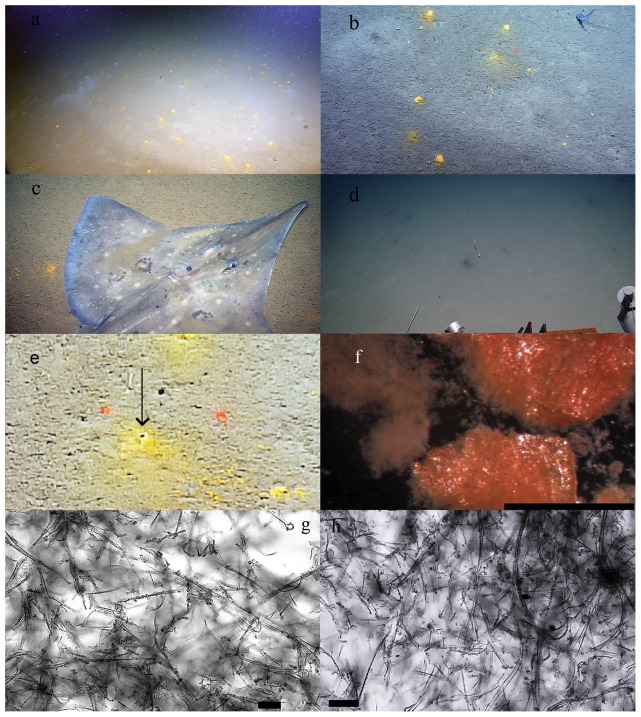
Images of the FeOB patchy mats observed in this study.a) Biofilm patches at the sediment-water interface of Dor disturbance. b) In situ close up image of the deposits, the distance between two red dots is 10 cm. c) Dipturus sp. re-suspending the deposits. d) Black-colored deposits in at 1000 m depth offshore Israel. e) Close up image of the FeOB patch. The arrow points at potential burrow opening at the core of the patch. f) Microscopic image of the deposits ex situ (scale bar is 0.5 mm). g, h) Microscopic images of the deposits (scale bar is 20 µm).